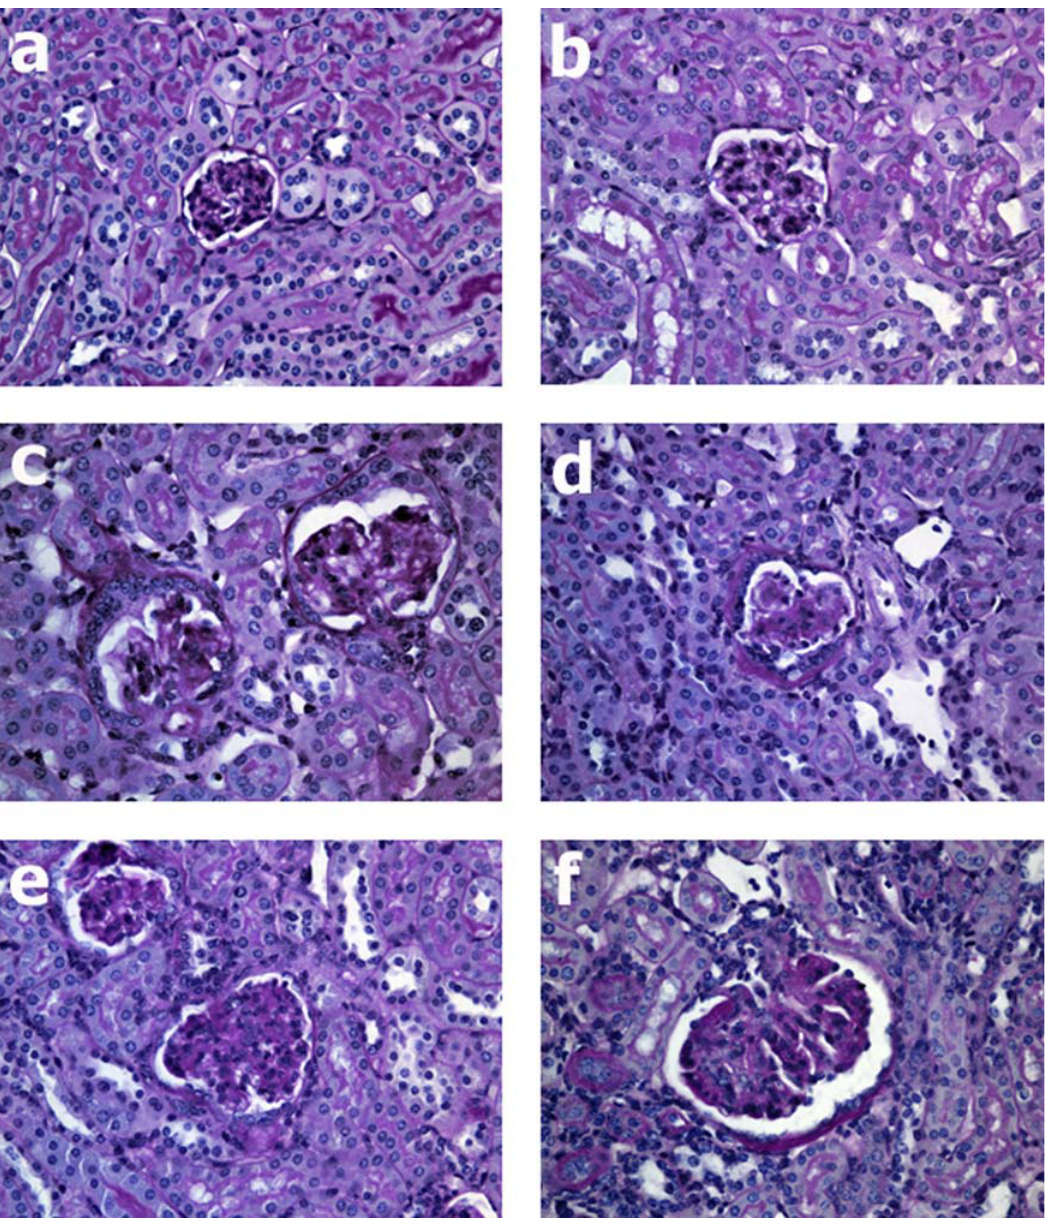
Figure 2. Histology of kidney sections. All sections were stained with Periodic Acid-Schiff stain; magnification 6 400. a: WT mouse treated with saline. b: C3KO mouse treated with saline. c: WT IR /WT mouse treated with HSA/LPS. d: C3KO IR /WT treated with HSA/LPS. e: WT IR /C3KO mouse treated with HSA/LPS. f: C3KO IR /C3KO treated with HSA/LPS.